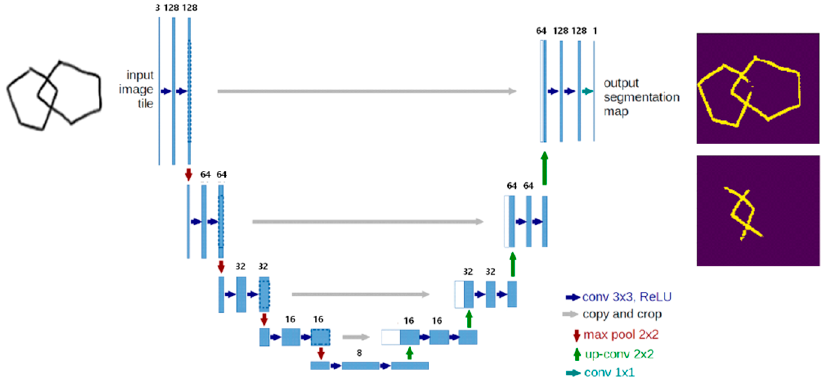
Figure 2. The U-Net network architecture used in this study.